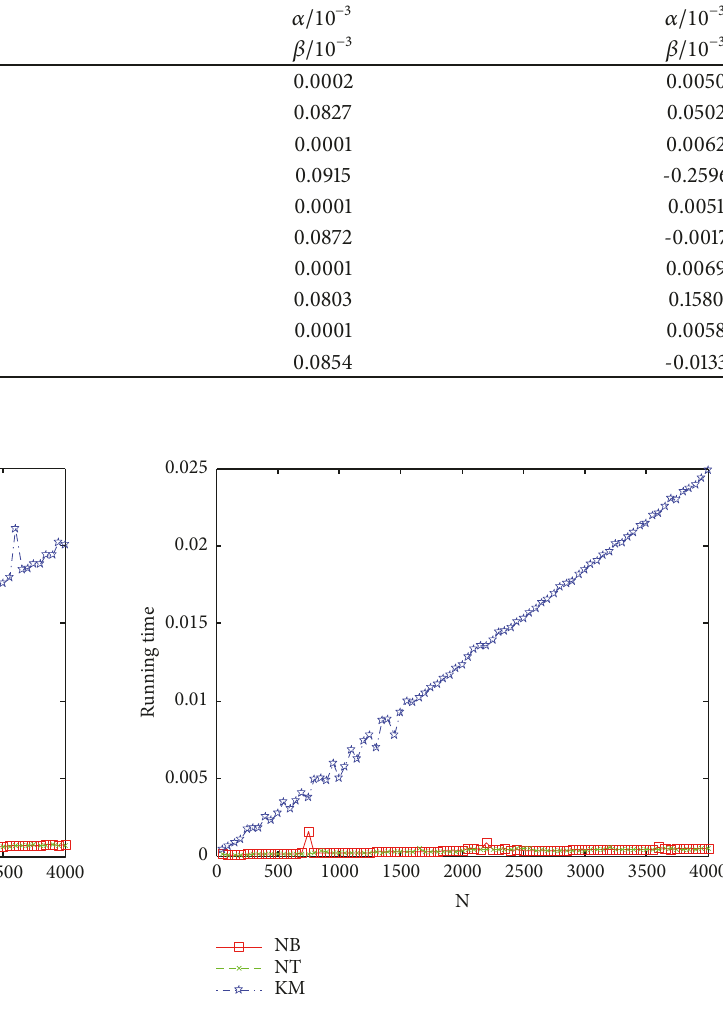
Figure 7: Computation time comparisons of example one. Figure 8: Computation time comparisons of example